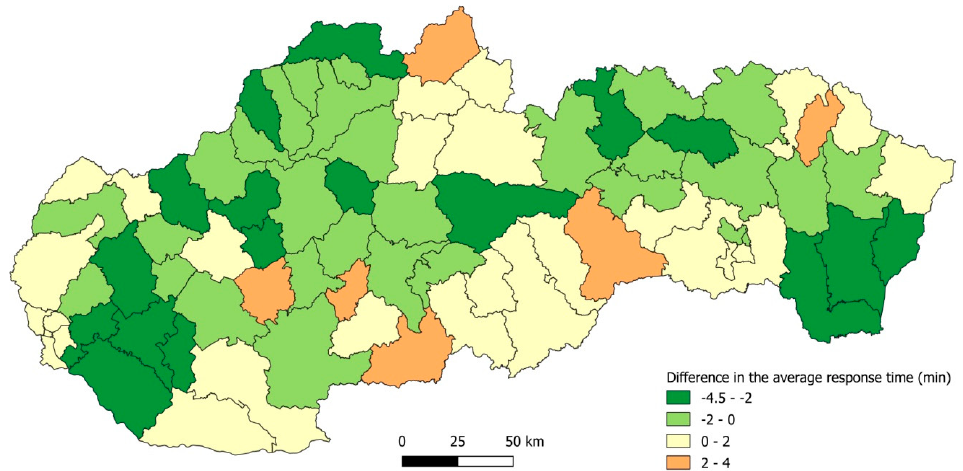
Figure 4. Difference in the average response time to the patients of priority K and N. A comparison of the 40% scenario with the current deployment of stations.